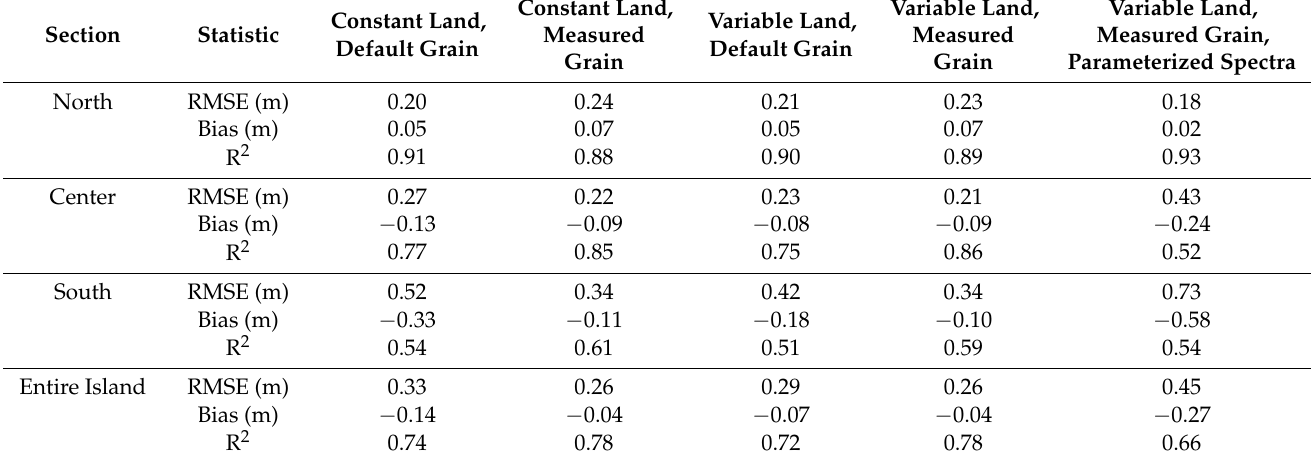
Table 5. Statistics comparing measured and modeled post-Florence bed levels for the different